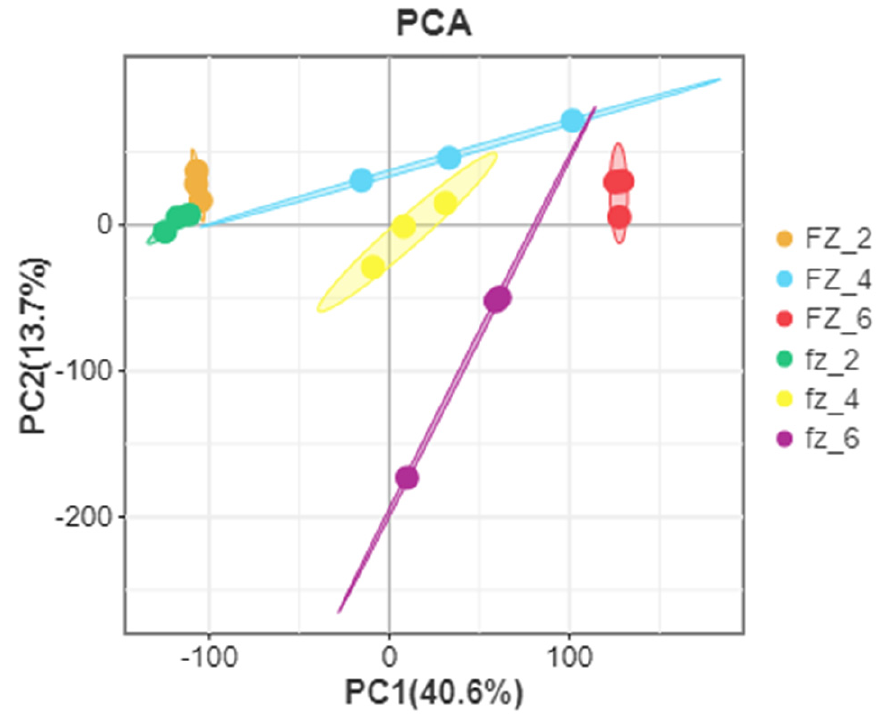
Figure 3. PCA analysis of CSS386 (FZ) and Sicala V-2 (fz).